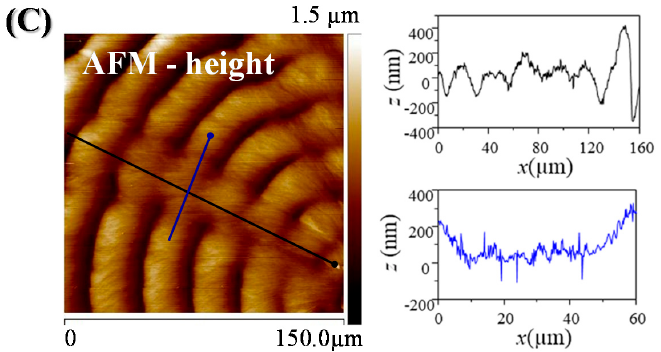
Figure 2. Comparison of AFM images and height profiles for ( A ) dislocation-free bands vs. ( B ) dislocated segments, ( C ) height profiles in the defect region in extinction ring bands of spherulites of P12T crystallized at 110 °C , 2 wt % (film thickness: 1.5–2 µm).